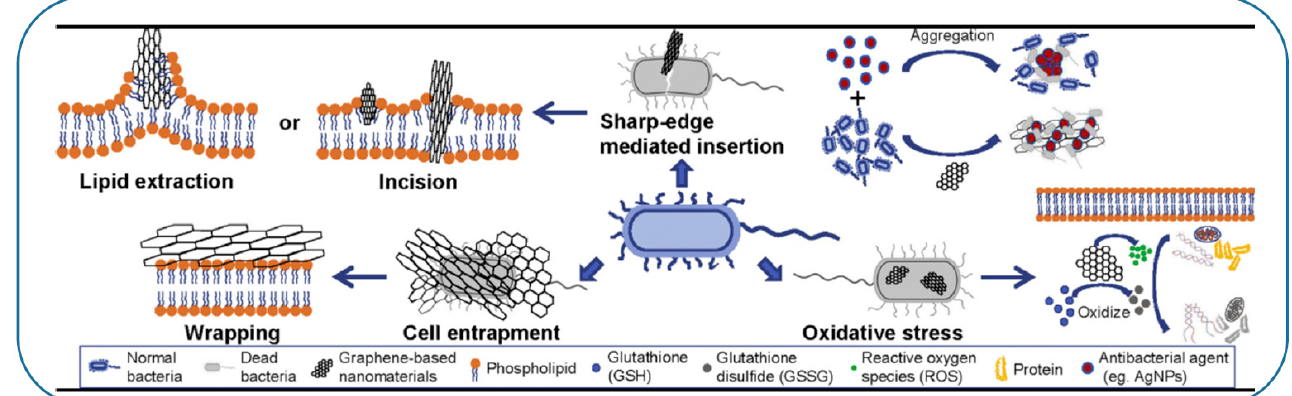
Figure 5. Schematic representation of different antimicrobial mechanisms of graphene based materials Reprinted with permission from ref. [56] Copy 2019 right from Elsevier.